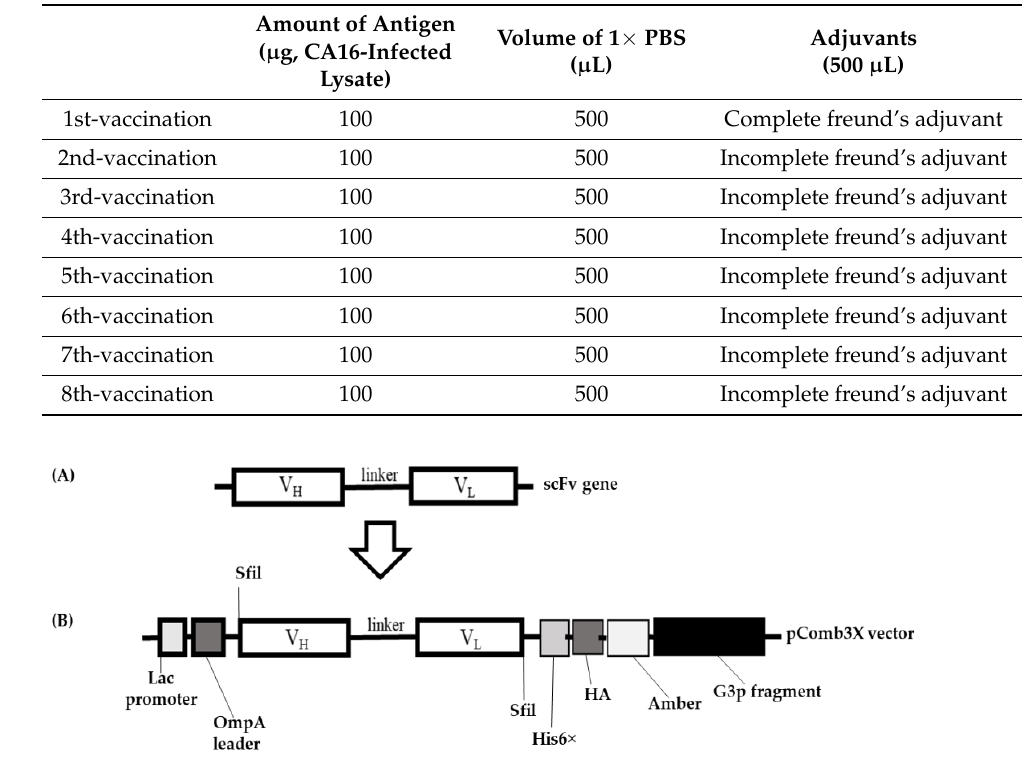
Figure 3. Schematic overview of single-chain variable fragment (scFv) gene cloning into the pComb3X plasmid. The arrangement of the V H and V L regions joined by a flexible linker representing the anti-CA16 scFv gene ( A ). The pComb3X gene constructs contained histidine (His6×) tag and hemagglutinin (HA) tag for detection and purification of recombinant scFv antibodies ( B ). The g3p fragment was included for the phage to display the scFv antibody protein on the surface of the viral particles.